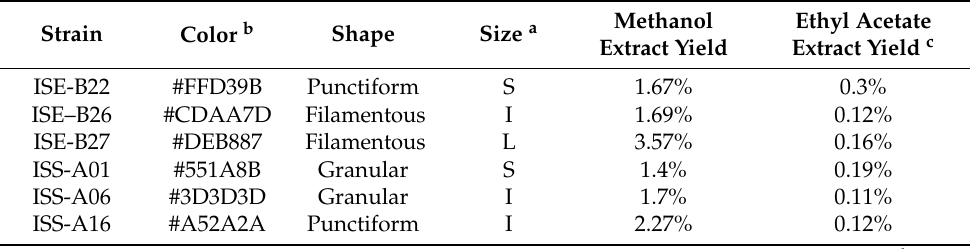
Figure 1. Isolated endophytic and rhizosphere Gram-positive bacteria from Ibervillea sonorae . Table 1. Colonies morphological characterization and yields of I. sonorae endophytic and rhizosphere bacteria extracts.